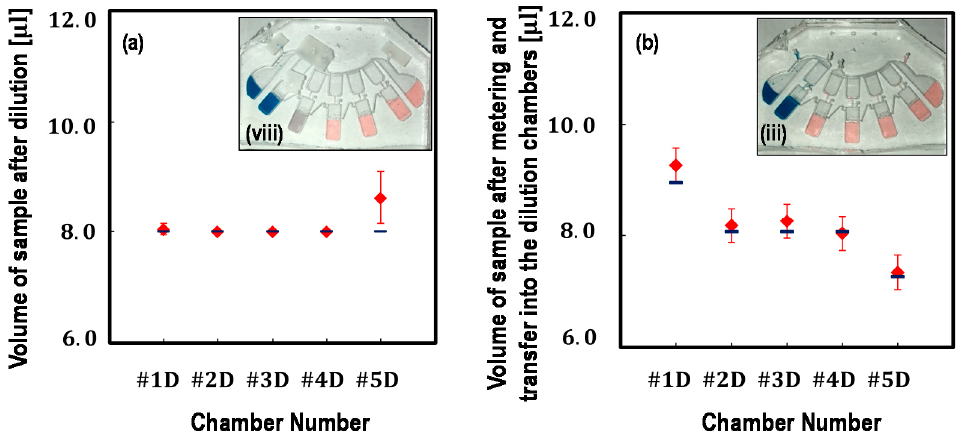
Figure 6. Volume analysis: ( a ) the measured volumes of liquids in each chamber after serial dilution (shown in Figure 4viii,viii’) and ( b ) the measured volumes of liquids in each chamber after metering and transfer into each dilution chamber (as shown in Figure 4iii). Digital micropipette aspiration was used to measure the sample volume. More than four test devices were used for measuring for ( a ) and ( b ), respectively. The insets indicate in which process the samples were collected for measuring.